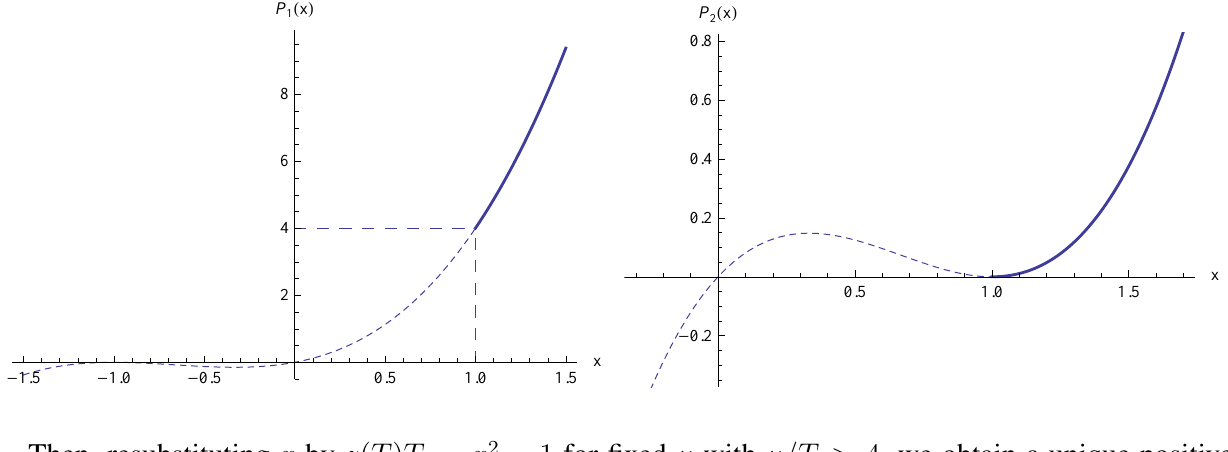
( x ) = x ( x − 1) 2 , see Equation 2